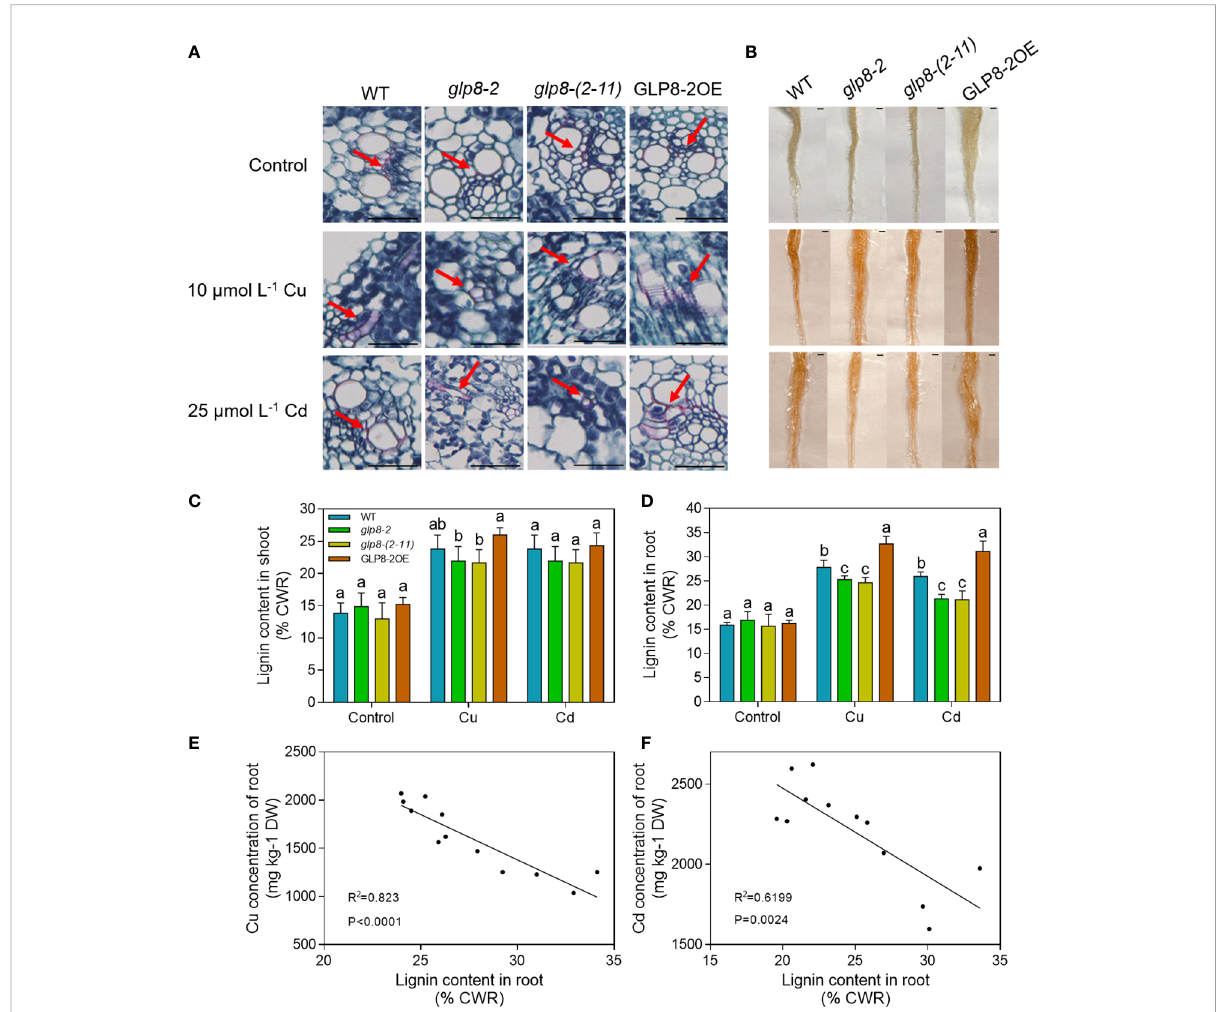
FIGURE 5 OsGLPs involved in lignin accumulation in rice. (A) Effects of Cu or Cd stress on lignin deposition in WT (wild type) and transgenic rice. Seedlings grew for 5 days under normal conditions, 10 m mol L − 1 CuSO 4 treatment, or 25 m mol L − 1 CdCl 2 treatment. The stems of the rice plants were stained with Safranin O-Fast Green, paraf fi n embedded, and sectioned. The magni fi cation was 400×. Red indicates that the lignin was successfully dyed. (B) Histochemical localisation of lignin in primary roots of two-week-old seedlings grown for 5 days under normal conditions, 10 m mol L − 1 CuSO 4 treatment, or 25 m mol L − 1 CdCl 2 treatment. The roots were stained with phloroglucinol solution, sliced, and placed on a stereo microscope to take pictures. Scale bar = 1 cm. (C, D) The lignin content in the root and shoot cell walls of two-week-old seedlings grown for 5 days under normal conditions, 10 m mol L − 1 CuSO 4 treatment, or 25 m mol L − 1 CdCl 2 treatment. (E, F) Correlation between root Cu/ Cd content in rice and lignin content in the root cell walls of rice. These seedlings were treated with 10 m mol L − 1 CuSO 4 or 25 m mol L − 1 CdCl 2 for 5 days. Values are the mean ± SD; n = 3. Different letters indicate a difference of p ≤ 0.05 using the LSD